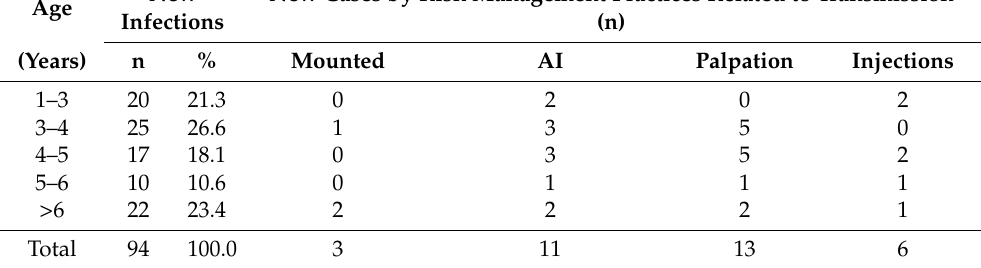
Table 2. Description of the number of new infections of Bovine Leukemia Virus and the number of those that were associated to some potential BLV transmission risk management